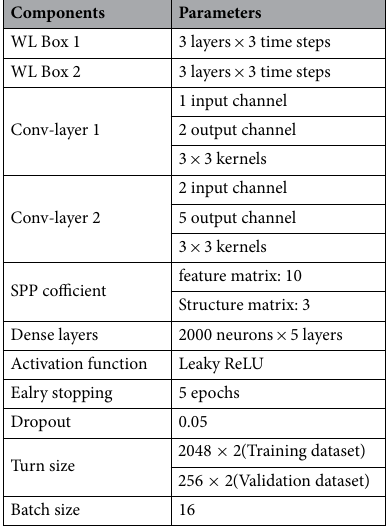
Table 1. Model setup.